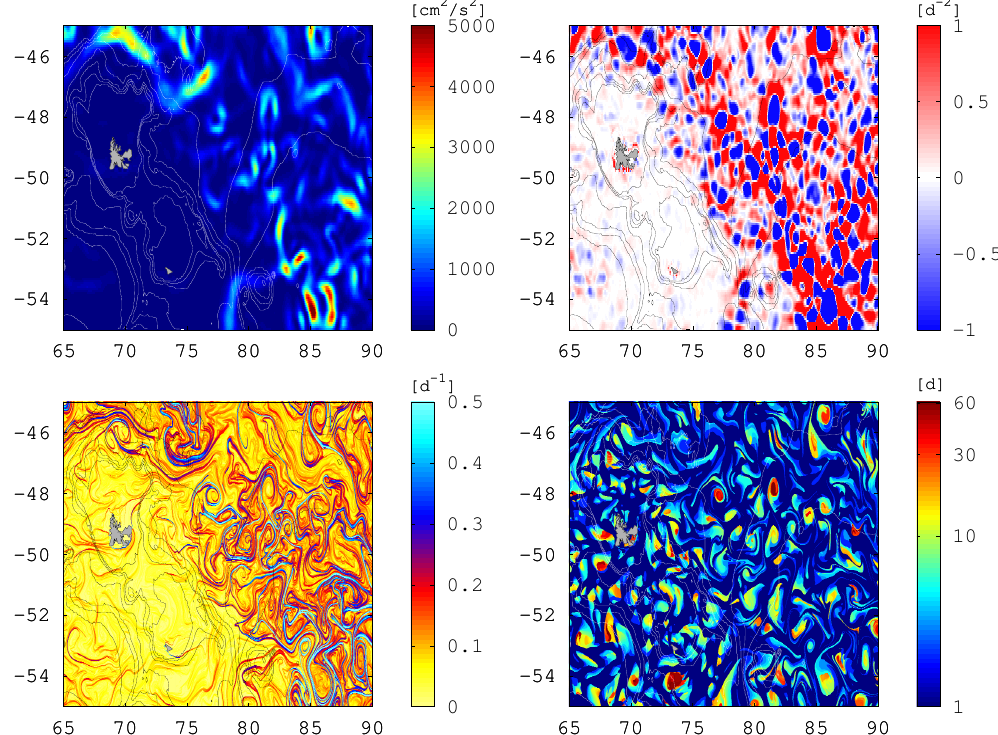
Figure 3. Lagrangian and Eulerian diagnostics derived from satellite altimetry: (top left) total kinetic energy; (top right) Okubo–Weiss parameter; (bottom left) Lyapunov exponents (finite-size); (bottom right) retention parameter. These maps were generated in near-real time for guiding the adaptive sampling strategy of the KEOPS2 cruise.